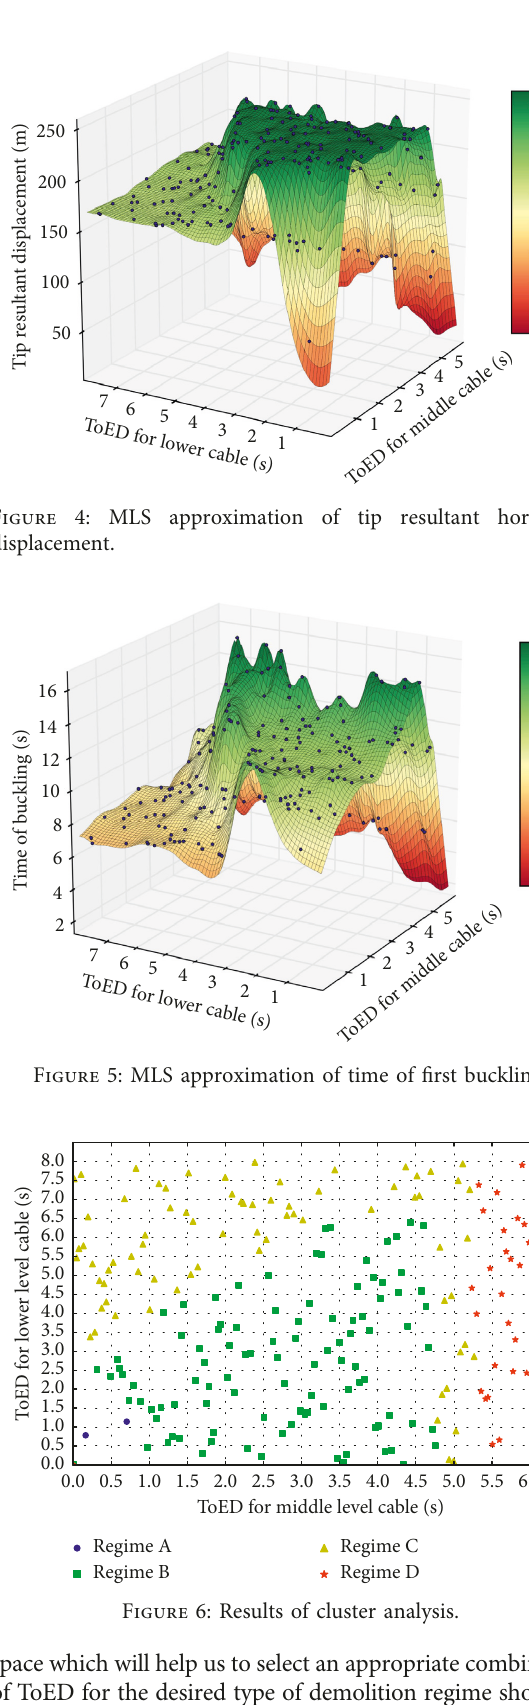
Figure 7. The case of Regime A is similar to the actual